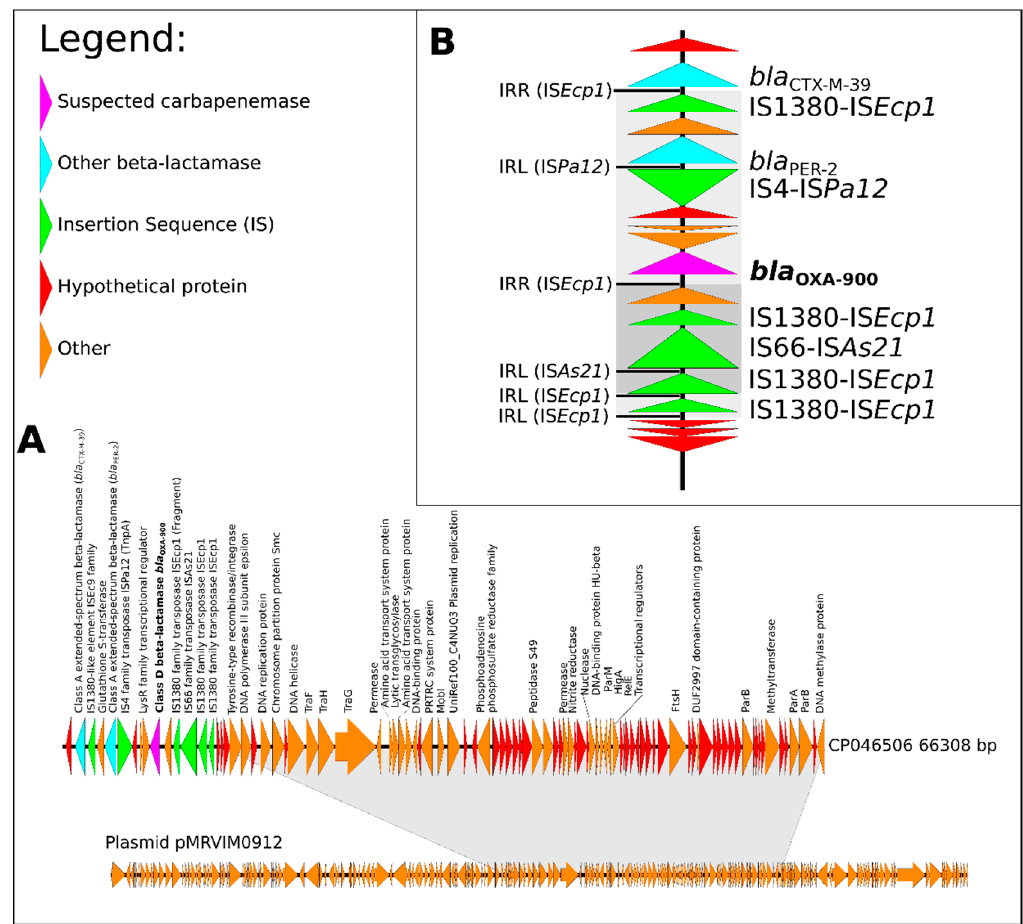
Figure 2. Genetic analysis of C. freundii plasmid CP046506 and its antibiotic resistance islands (ARI): ( A ) plasmid CP046506, a version of pMRVIM0912 with an ARI on which the new bla OXA-900 was found (regions of similarity are marked in grey); ( B ) ARI with two ESBL genes and a novel carbapenemase. All IS inverted repeats on the right (IRR) and on the left (IRL) are marked and the region suggested to be inserted by the IS Ecp1 is marked in grey shades. Triangles represent ORFs: hypothetical proteins are marked in red, annotated genes in orange, IS fragments in green, the carbapenemase is marked in purple and other β -lactamases in blue.